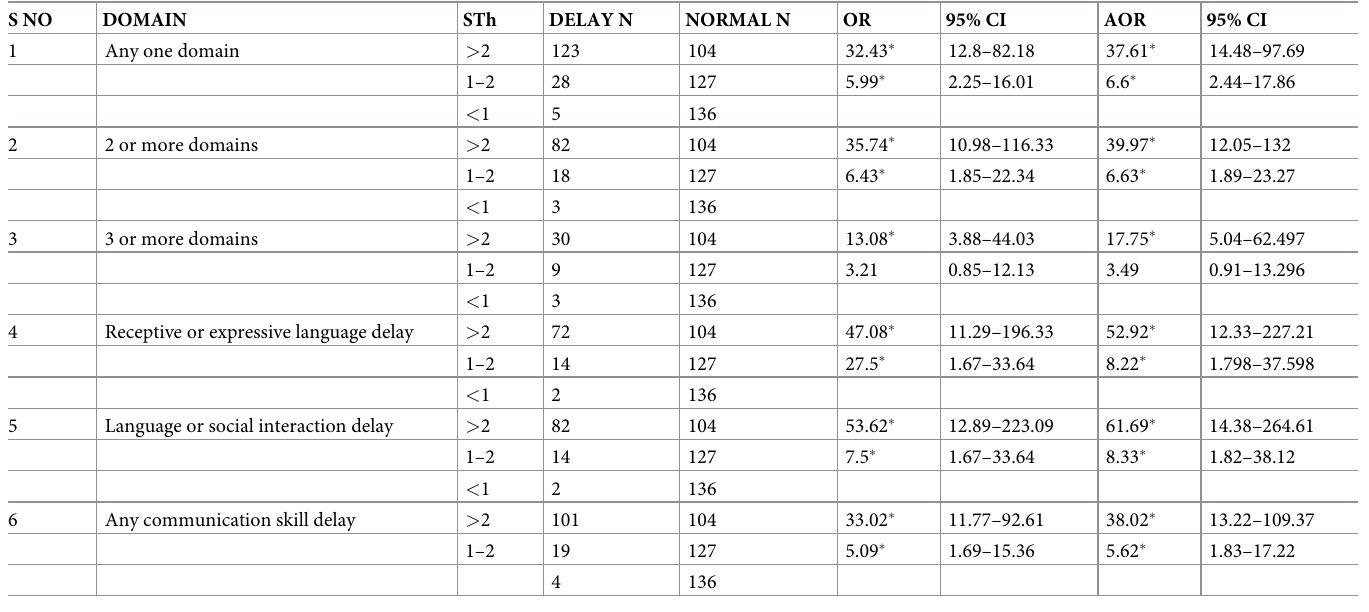
Table 5. Association between screen time in hours (STh) and child development among children aged 24–60 months.